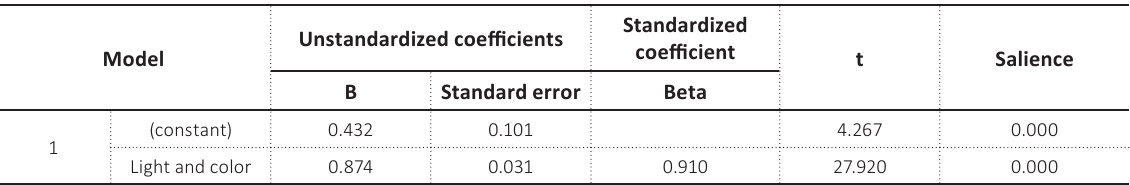
Table 5. Linear regression coefficients of the relationship between light and color and brand image